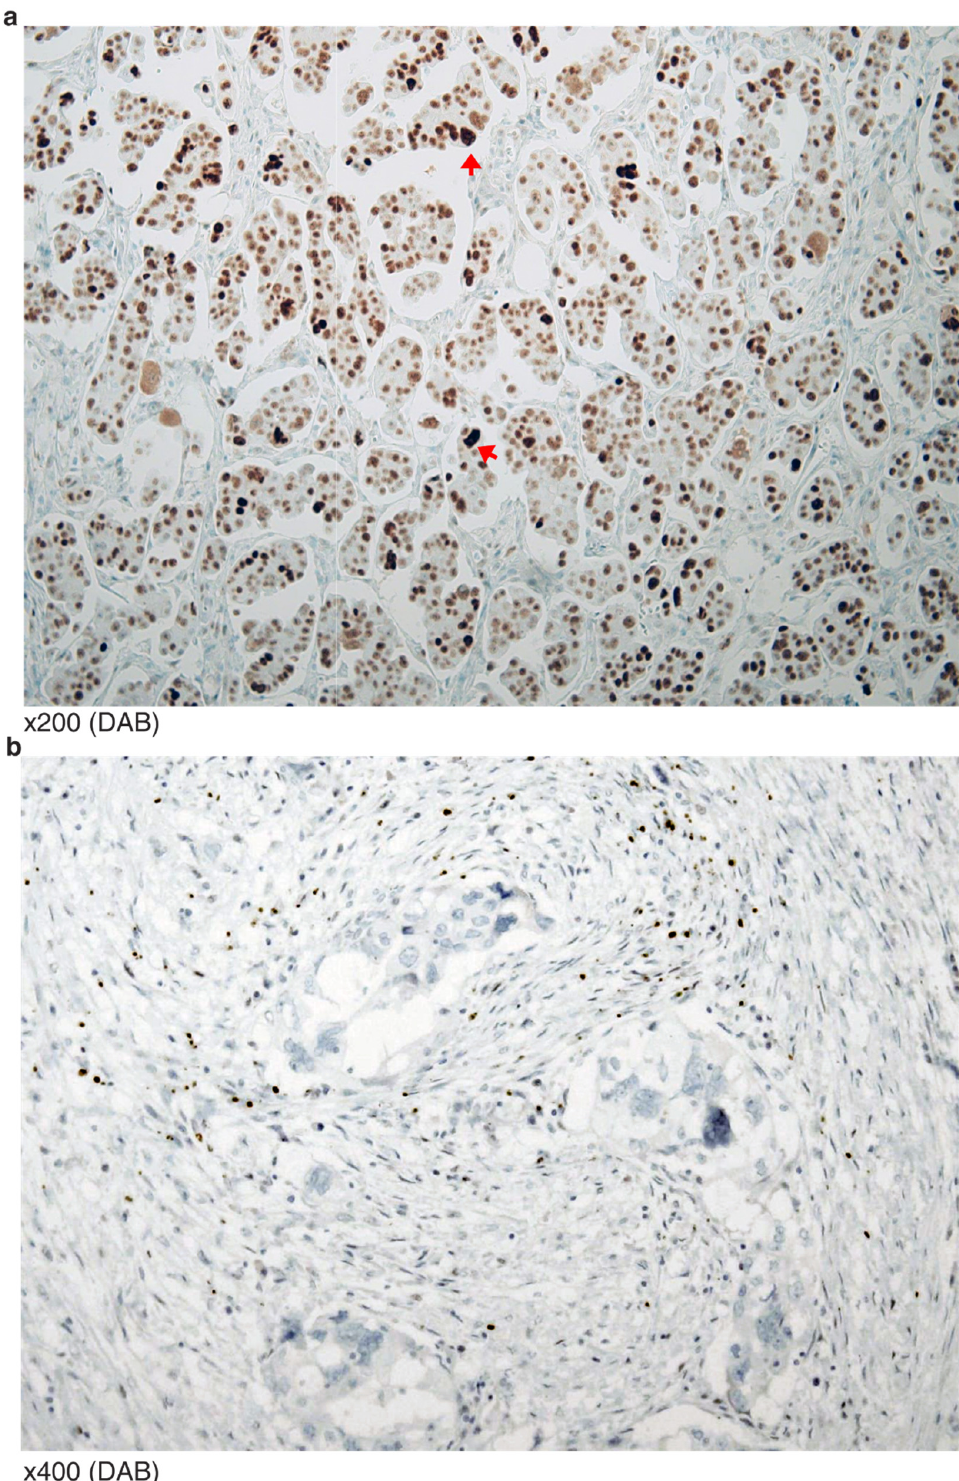
Figure 2. Typical p53 mutation staining of HGSCa: ( a ) All tumor nuclei are strongly positive for p53. Aneuploidy cells are relatively stronger (arrowheads) than the remaining tumor cells; ( b ) no positive stained tumor cell, or “none” pattern.